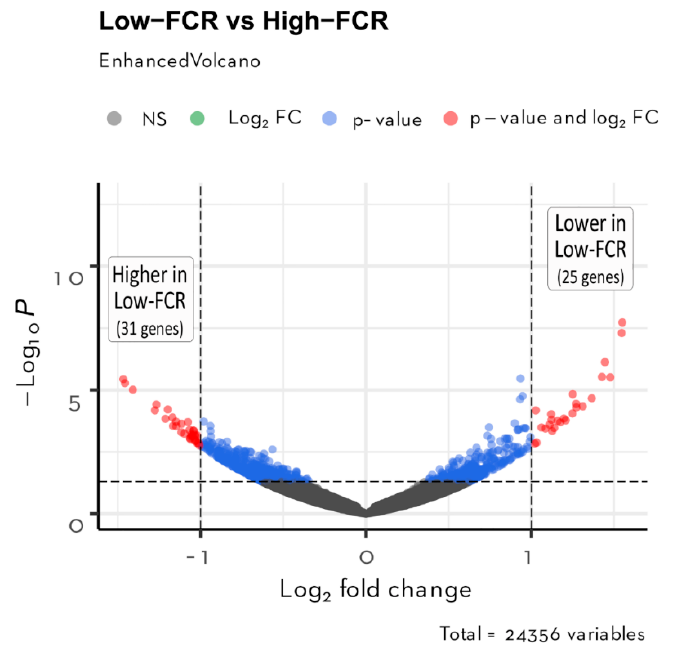
Figure 2. Principal component analysis (PCA) plot of the transcripts identified in high- and low- FCR samples. The ellipses represent 95% confidence intervals for each group. No outliers were ob- served. The abscissa and ordinate each represent a principal component, and the percentage repre- sents the amount of variation between samples. R2X represents the accumulated variance contribu- tion rate.